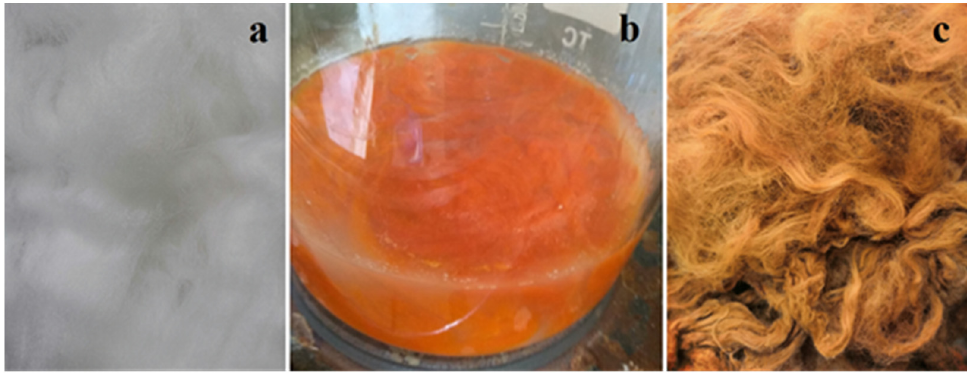
Figure 4. PAN fiber: ( a )—initial before treatment with NaOH; ( b )—after treatment with NaOH (red fiber); ( c )—ready product.